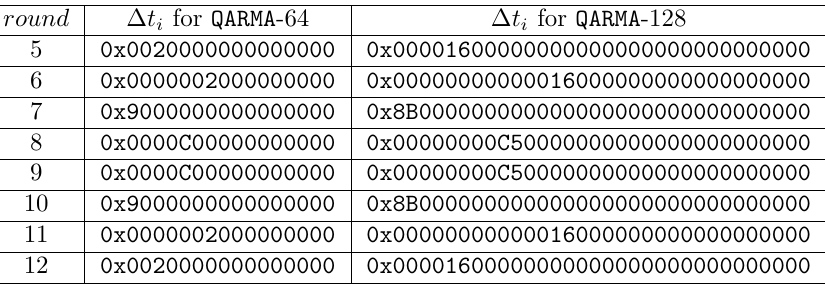
Table 7: Difference of Round Tweak for No. 2 Distinguisher